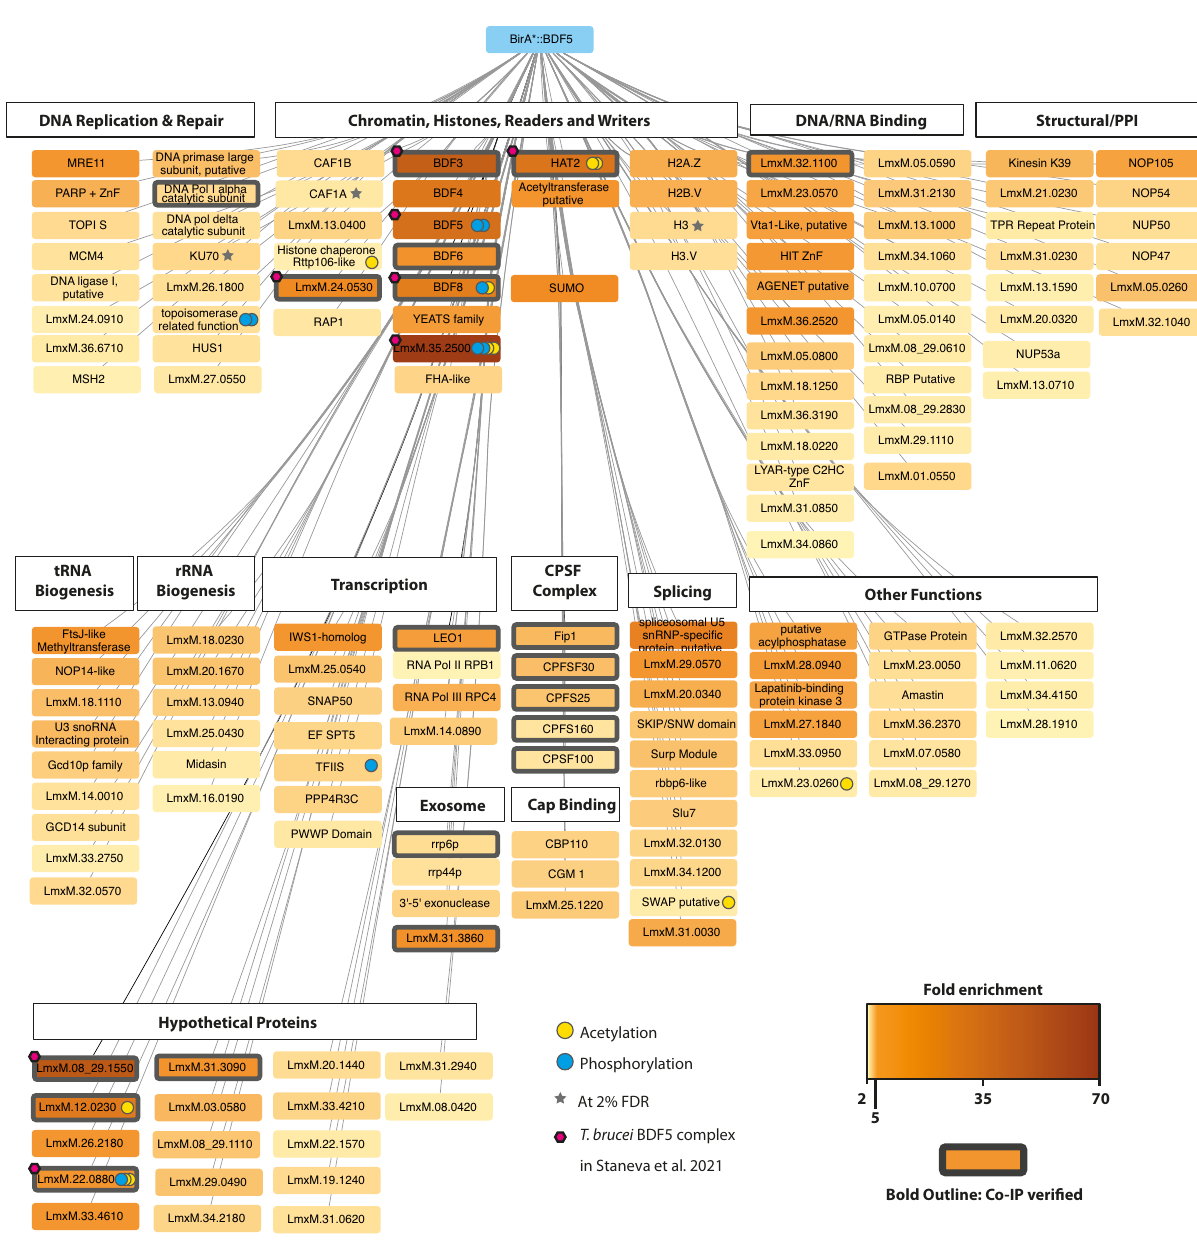
Fig. 5 The BDF5-proximal proteome determined by XL-BioID. Network indicates proteins determined to be spatially enriched in proximity to BirA*::BDF5 following in vivo biotin labelling and DSP crosslinking during the XL-BioID work fl ow. Biotinylated material was enriched using streptavidin magnetic